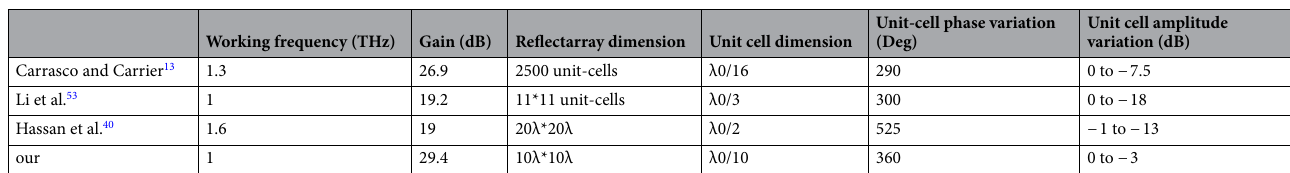
Table 2. Performance comparison of the proposed antenna and other grapheme based reflectarrays.